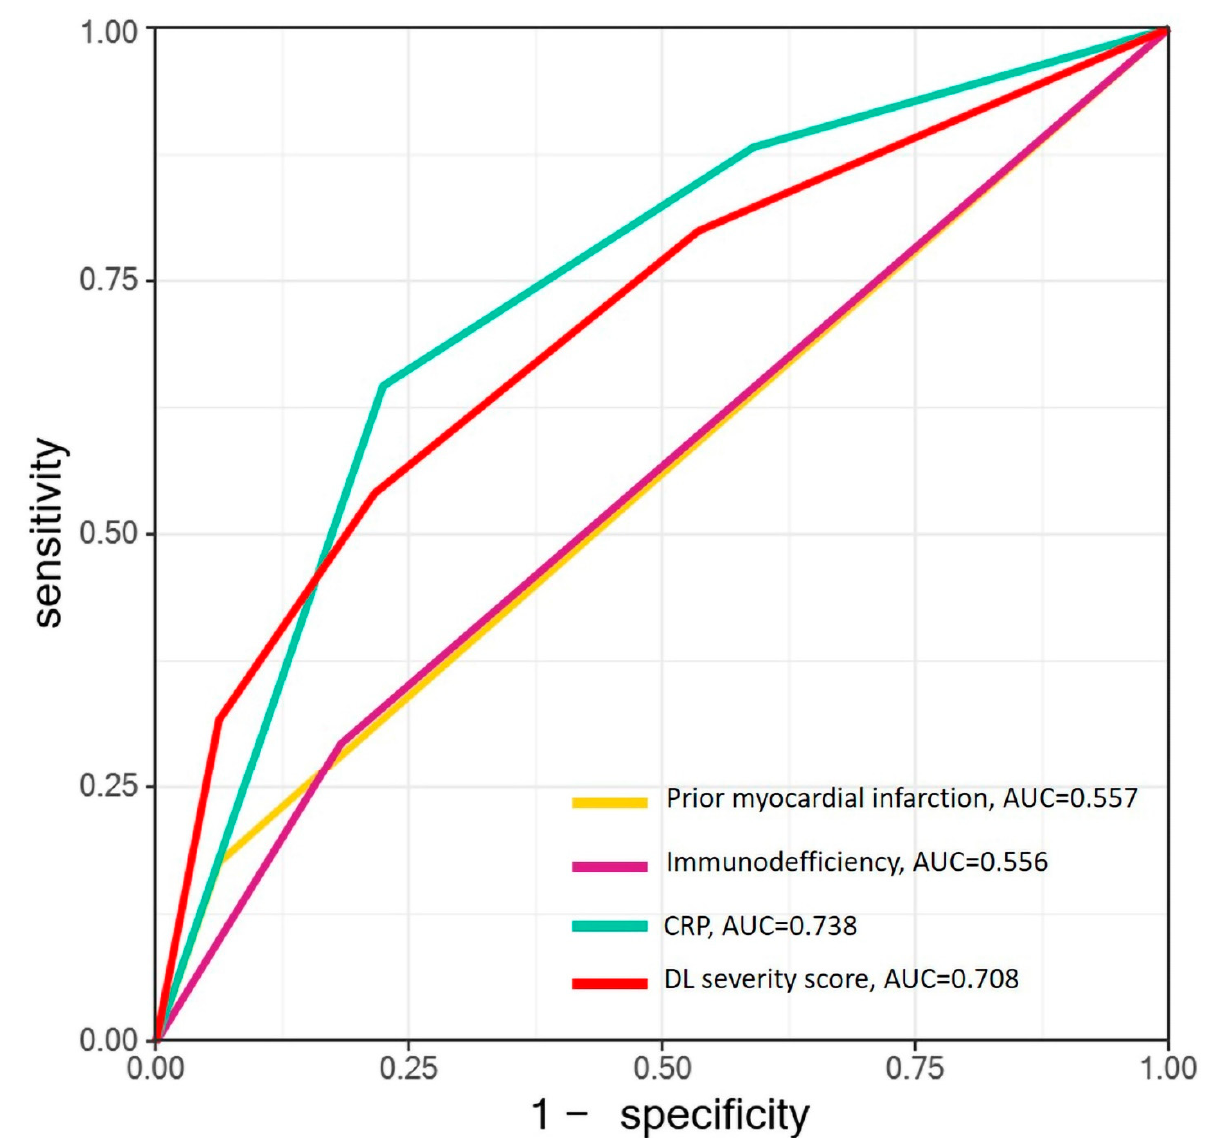
Figure A4. ROC analysis of independent predictors. Abbreviations: AUC = area under curve, CRP = C-reactive protein, DL = deep learning.